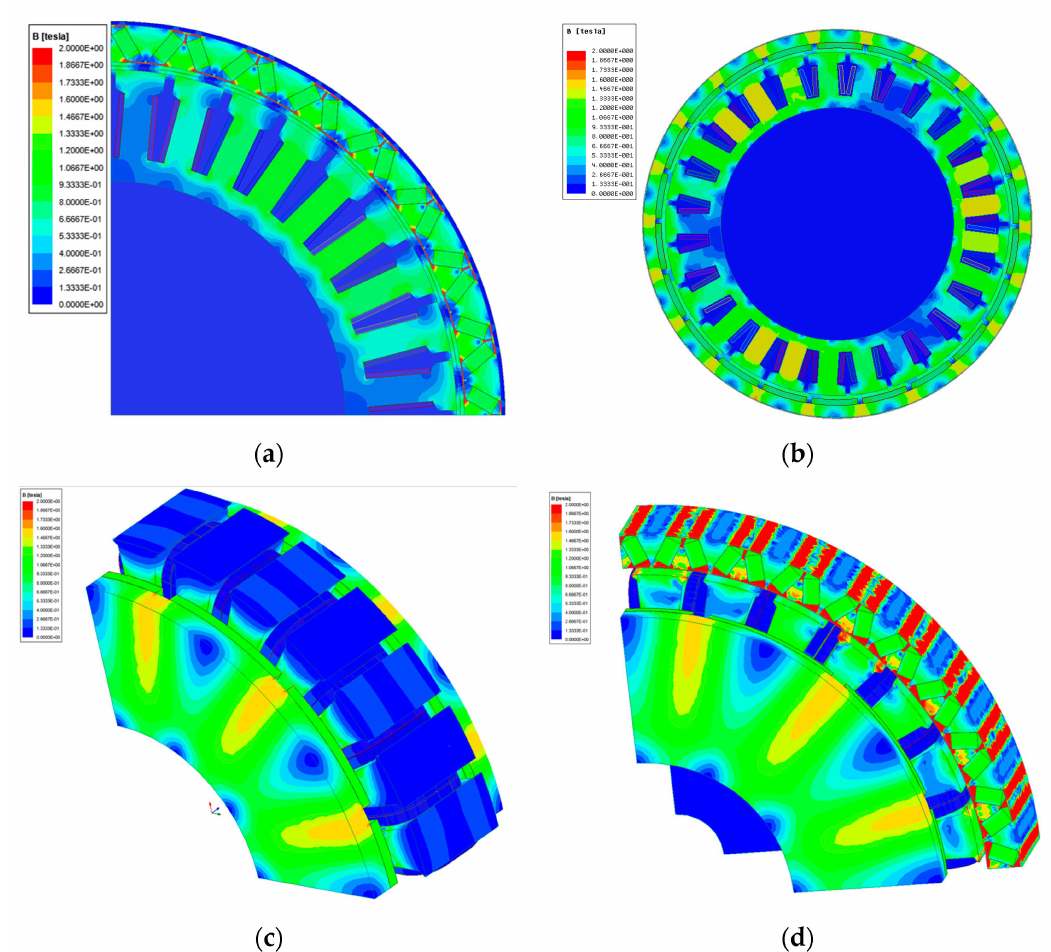
Figure 5. No-load flux density distribution with the same scale bars of ( a ) three-phase IPM; ( b ) five- phase SPM; ( c ) seven-phase AFM; ( d ) seven-phase HFM.